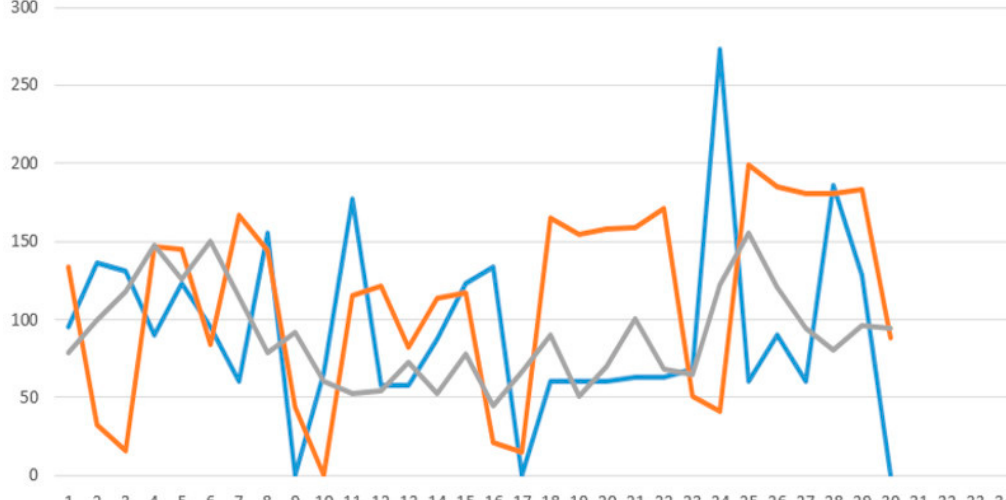
Figure 13. Daily power demand and search frequency for “intense heat” and “air conditioner” in August 2018.